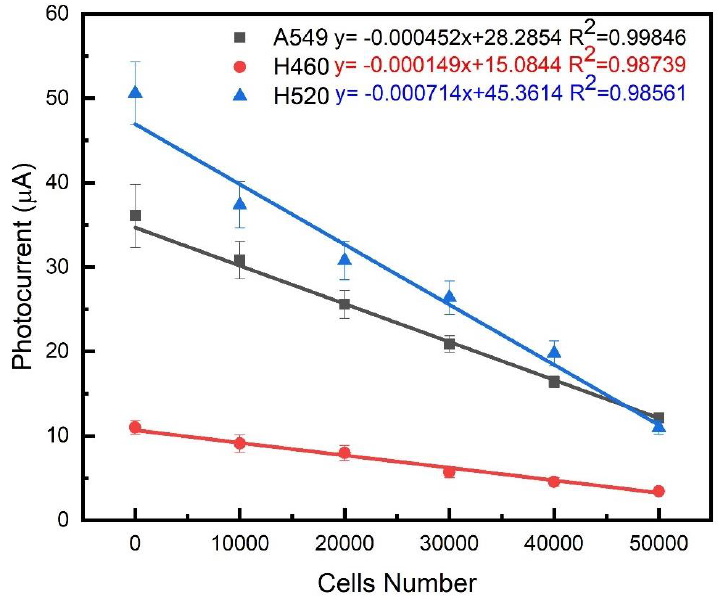
Figure 10. Linear relationship between photocurrent changes and cell number in three lung cancer cell lines on biosensing chips .